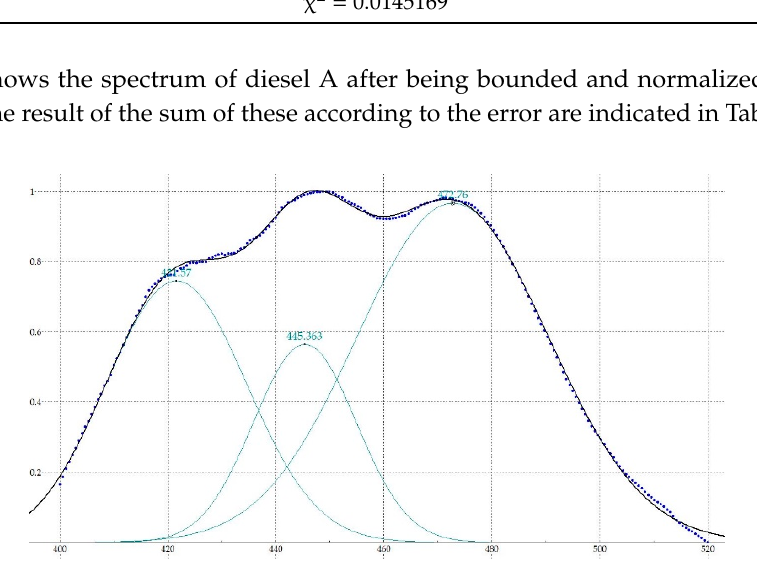
Figure 4. Spectrum after being bounded and normalized (dots), Gaussian functions (green) and sum of functions resultant (black).